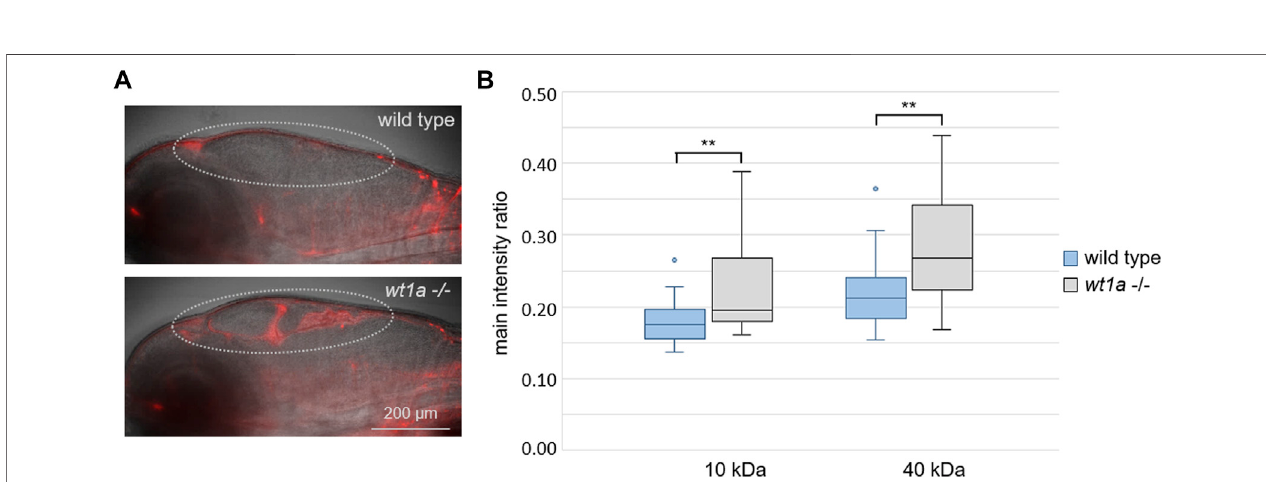
FIGURE5| Wt1a inactivation reduces theblood-CSF barrierfunction.Fluorescently labeled dextranswereinjected intothe cardinal veinof5 days old larvaeofthe wt1a ex1_del5 lineandleakage intotheventricleswasanalyzed. (A) Representativeoverlayimagesoftransmissionand rhodamin-dextran(10 KDa) fl uorescencerecorded by light sheet microscopy of larvae that were fi xed 4 h after injection. The dotted line marks the ventricular system. (B) Ratios of fl uorescence intensities of rhodamin- dextran (10 KDa) and fl uorescein-dextran (40 kDa) in the ventriclular region relative to the respective fl uorescence in the pupil were estimated in vivo 40 min post injections. n (cid:1) 24 for wild types and 22 for mutants; p -values according to ANOVA: 0.003 and 0.002 (**) for 10 and 40 kDa, respectively.